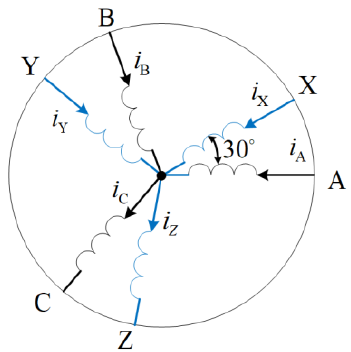
Figure 2. Stator Winding Structure of Six Phase PMSM.